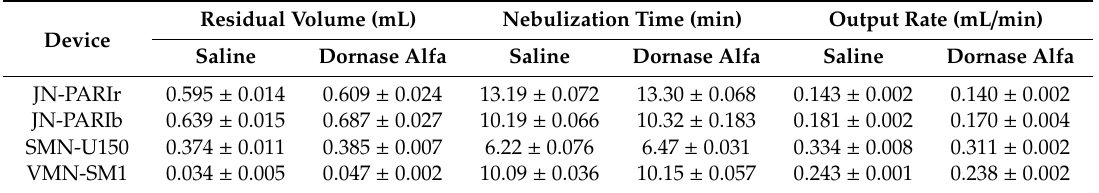
Table 3. Residual volumes, nebulization times, and output rates for the four nebulizers.